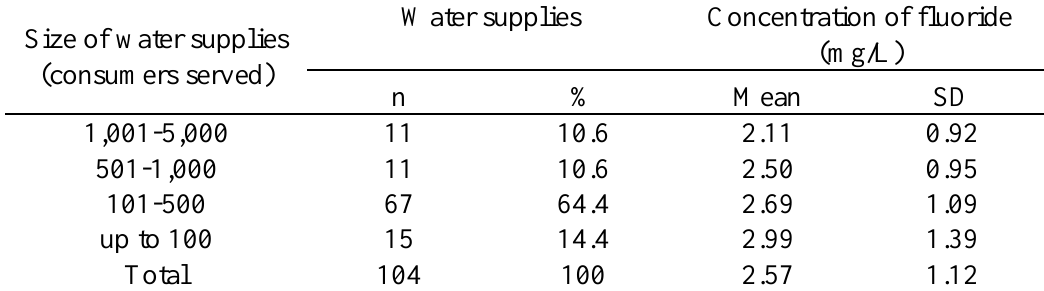
Table 1. Distribution of high-fluoride water supplies by number of consumers